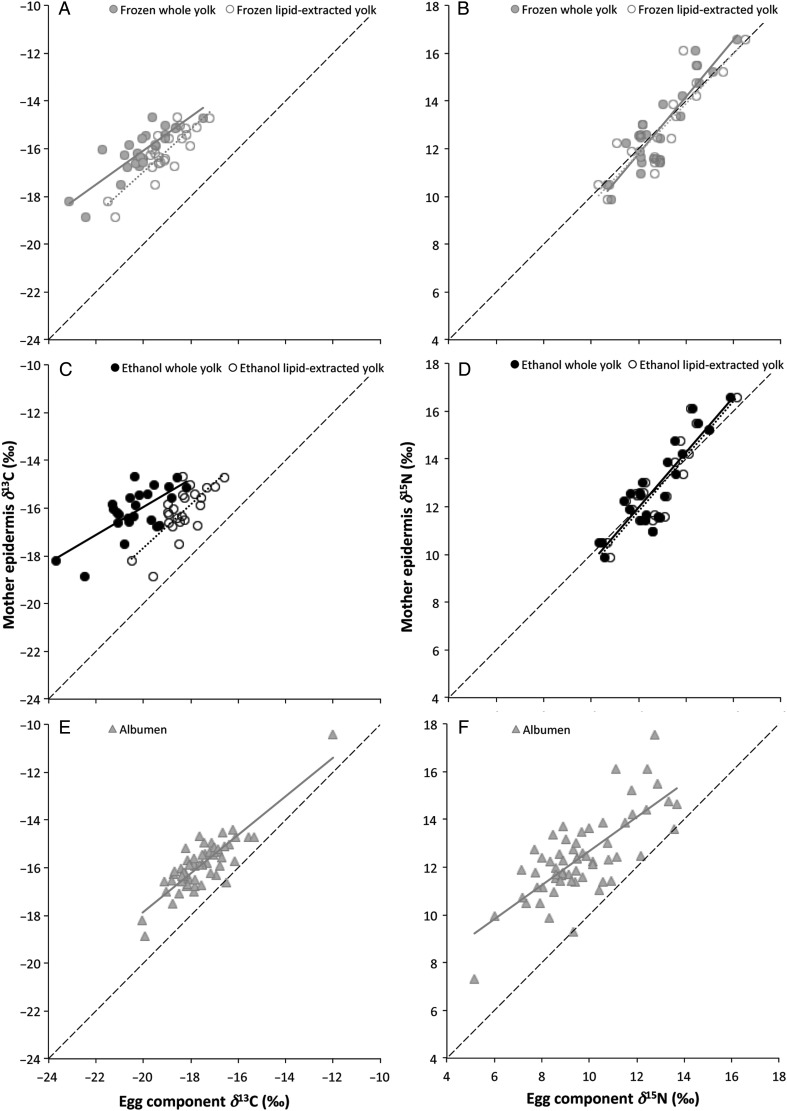
Linear relationships between maternal epidermis and egg component δ13C (A, C and E) and δ15N values (B, D and F). Four different yolk treatments (A–D; n = 24) as well as albumen (E and F; n = 61) were examined. All relationships shown are significant (P < 0.001), and equations are provided in Table 5. The length of the regression line corresponds to the range of stable isotope values measured in the present study. A one-to-one line is provided for reference in each panel.